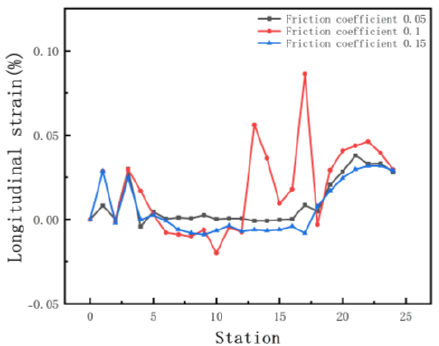
Figure 14. Longitudinal strain of strip in 3 friction coefficients.